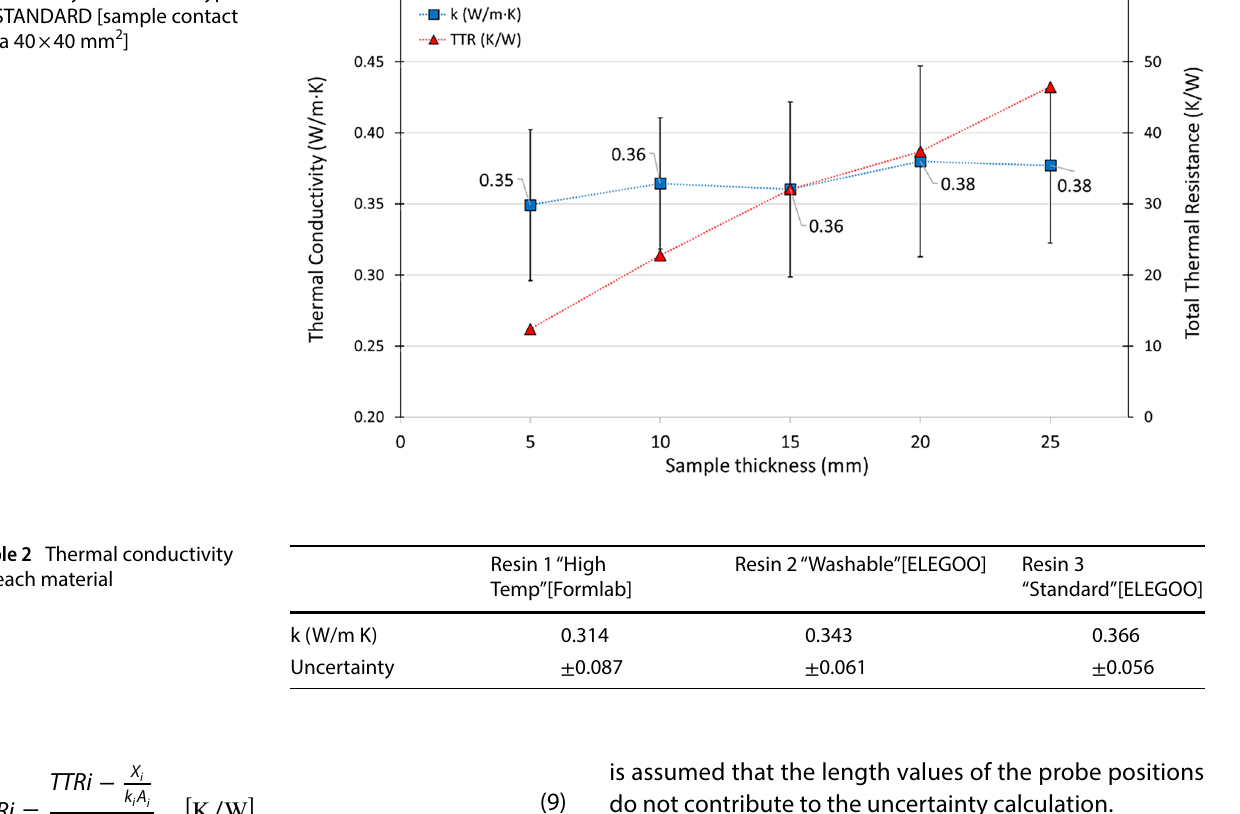
Resin 1 “High Temp”[Formlab]